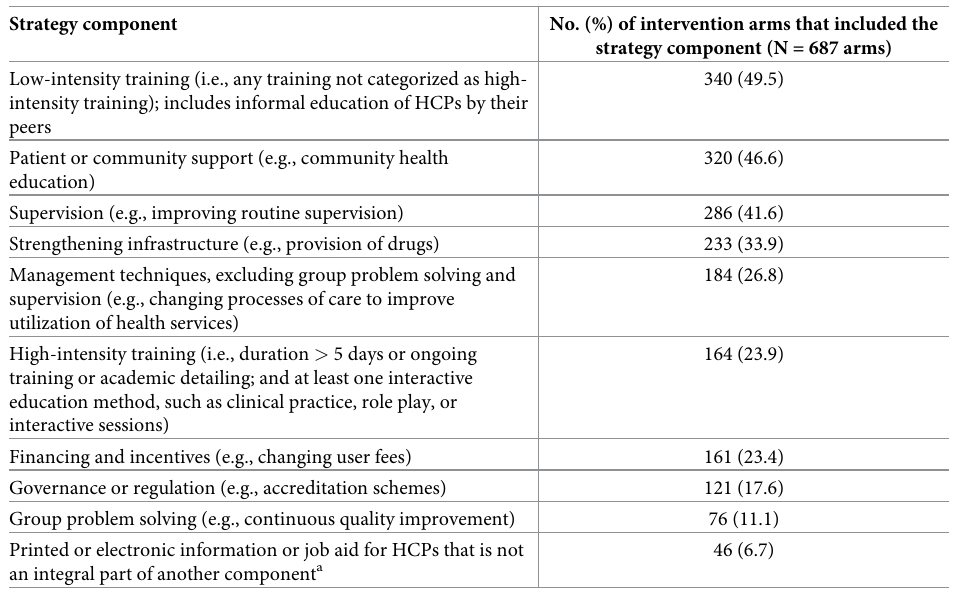
Table 6. Distribution of strategy components across all intervention